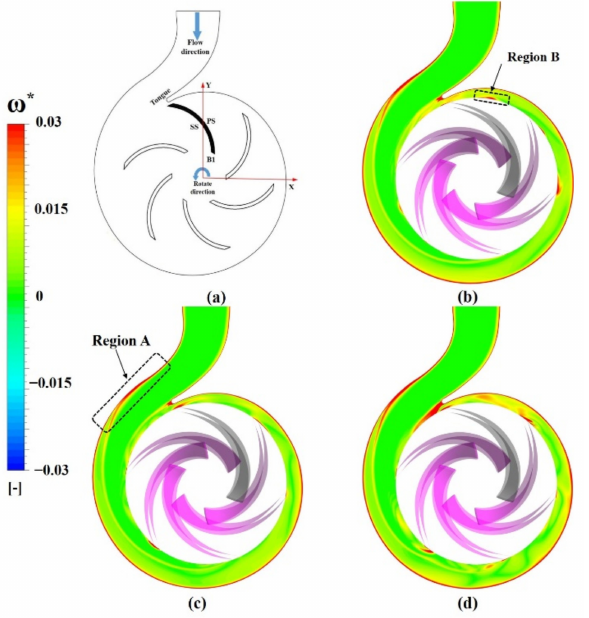
Figure 8. Spatial distribution of vorticity in the volute. ( a ) Diagram of the volute and impeller; ( b ) 0.7 Q b ; ( c ) Q b ; ( d ) 1.3 Q b